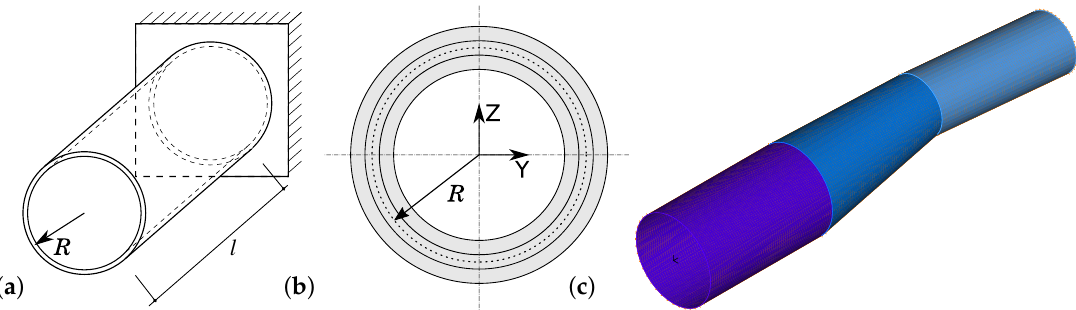
Figure 1. The considered models: ( a ) MODEL1 (laminate tube); ( b ) MODEL1 cross-section; ( c ) MODEL2 (three-section shell